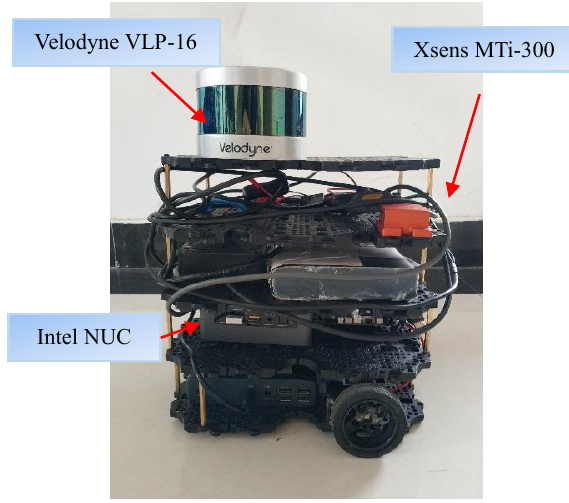
Figure 1. Two-wheeled robot-borne laser scanning system The laser scanner used in the system is Velodyne VLP-16. It has a 100 meter measuring range and the vertical field of view(FOV) is ±15°. The horizontal angle resolution varies from 0.1° to 0.4°